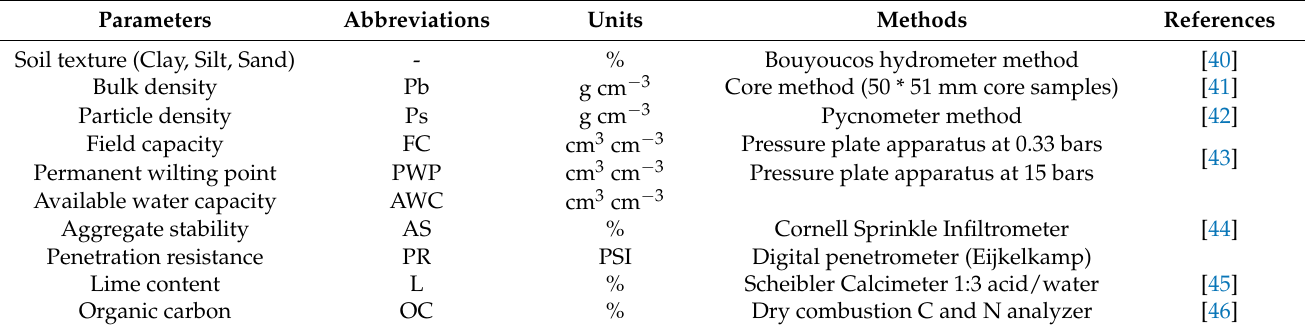
Table 1. Measurement methods of the soil input data.